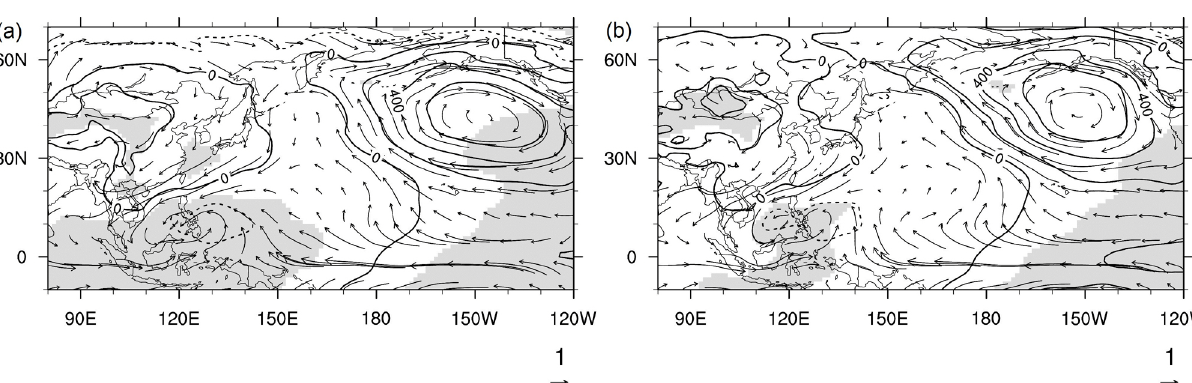
Figure 3. Spatial patterns of composite differences between strong and weak phases of ( a ) PCpri and ( b ) PC1sec. The vector and contour line are the differences of wind (meters per second) and sea level pressure (hectopascals), respectively, and the shading contour is the 0.05 significance